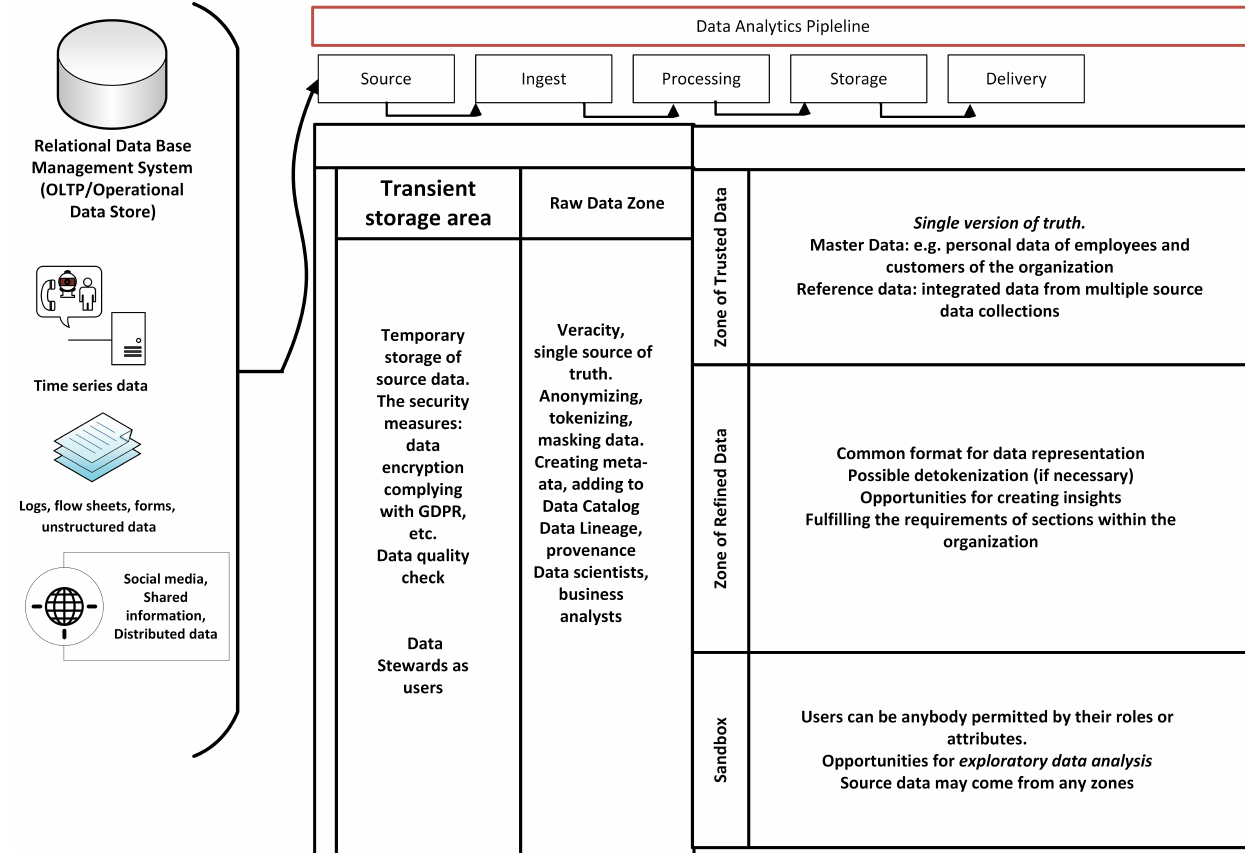
Figure 2. Data lake reference architecture along with the data analytics pipeline a . a In the data analytics pipeline, the information passes five phases , from information being a “Source” , that is raw information for which veracity needs to be checked, to information going through the phases of “Ingest”, “Processing”, “Storage”, and “Delivery” , where the single version of the truth is composed, a common format for data representation is found, and opportunities for creating insights and exploratory data analysis are provided for the company. The editing of the figure was based on